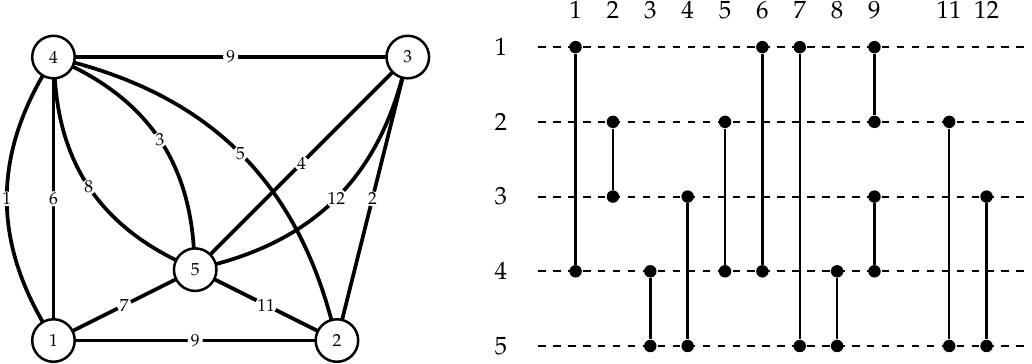
Figure 2. An example of temporal graph with five nodes and 12 temporal edges (labels on edges represent appearing time), and the corresponding link stream representation (labels on the left represent nodes, labels above represent time